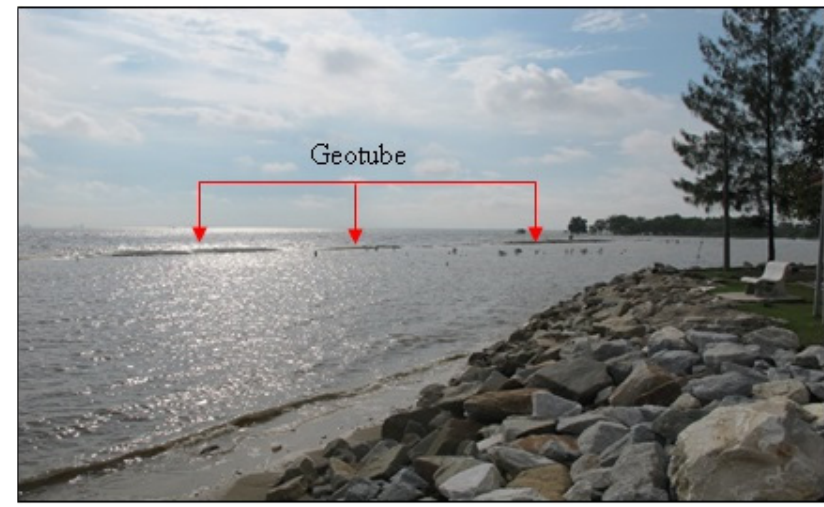
Figure 2. Photo showing geotube installed at Pantai Kelanang in 2019.